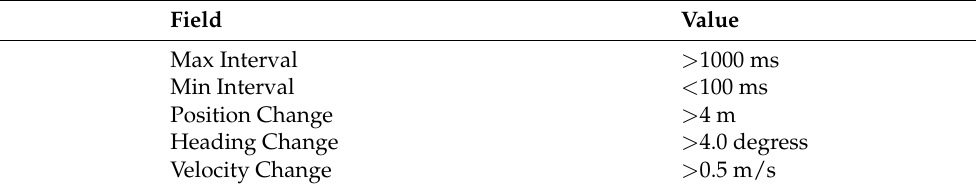
Heading Change Velocity